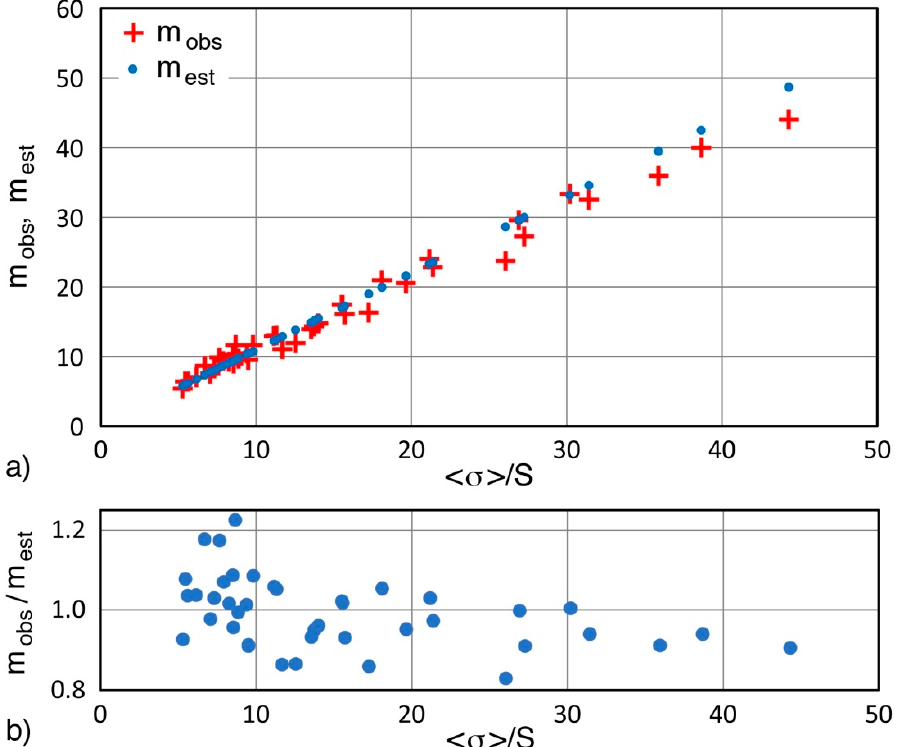
Figure 8. ( a ) Plots of m obs (red + symbol) and m est (blue dot) vs. < σ >/ S for composite data. ( b ) Plot of m obs / m est (blue dot) vs. < σ >/ S for the same.